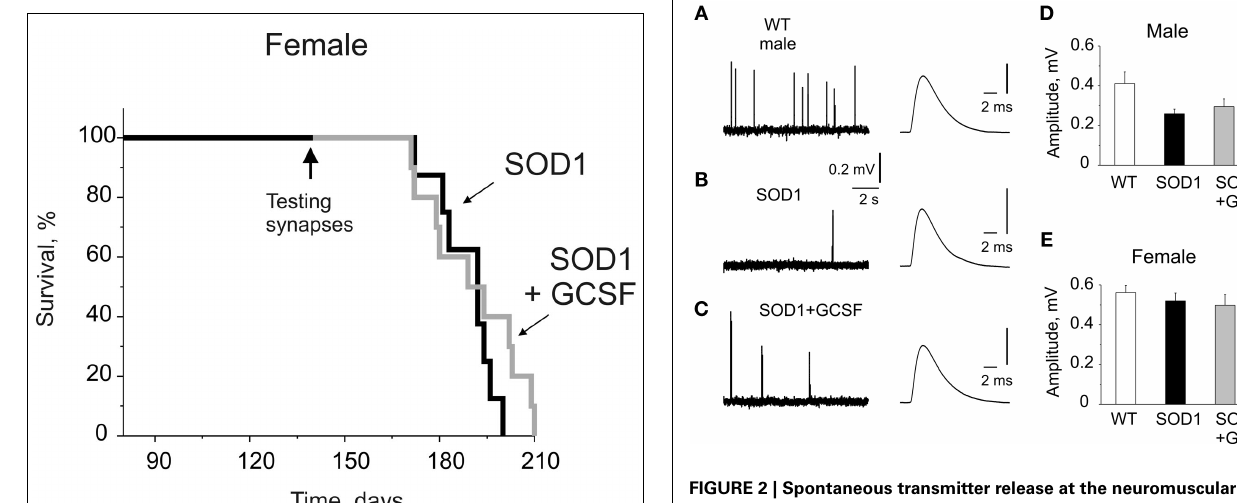
FIGURE 2 | Spontaneous transmitter release at the neuromuscular junctions ofWT, G93A-SOD1, and GCSF-treated G93A-SOD1 mice. (A–C) Examples of miniature end-plate potentials (MEPPs) inWT, G93A-SOD1, and GCSF-treated G93A-SOD1 mice, respectively (right, averaged MEPPs are shown in expanded scale). Note largely reduced frequency of MEPPs in G93A-SOD1 mice and improvement of this parameter in GCSF-treated animals. (D,E) . Histograms showing MEPPs amplitude inWT, G93A-SOD1, and GCSF-treated G93A-SOD1 mice in males (D) and females (E) 80–140 MEPPs were averaged in every